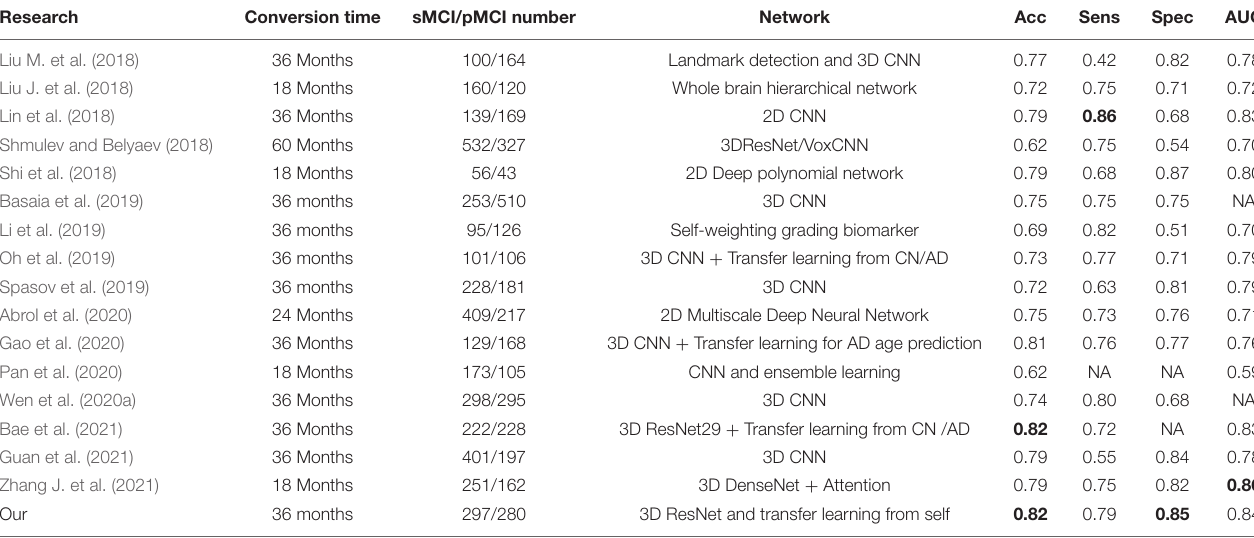
FIGURE 8 | The heatmap of related brain region our model focuses on. The first row is a golden standard of temporal superior, temporal middle, hippocampus, thalamus, precuneus, cingulate in automated anatomical labeling (AAL2, http://www.gin.cnrs.fr/en/tools/aal-aal2/). The second and third rows show brain regions that our model focuses on more on sMCI and pMCI, respectively. pMCI, progressive mild cognitive impairment; sMCI, stable mild cognitive impairment. TABLE 4 | A summarized comparison of state-of-the-art research on MRI using deep learning in sMCI and pMCI